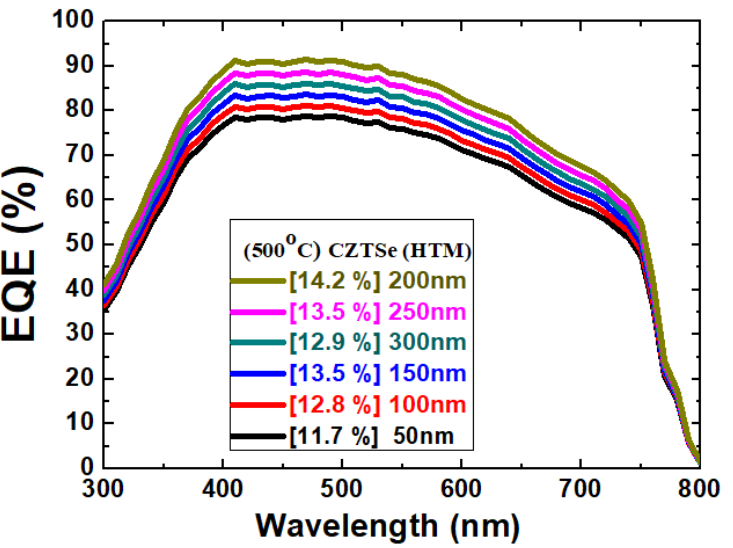
Figure 8. EQE spectra for the Ag/C 60 /MAPbI 3 /CZTSe/Mo/FTO thin-film solar cells with various CZTSe film thicknesses.